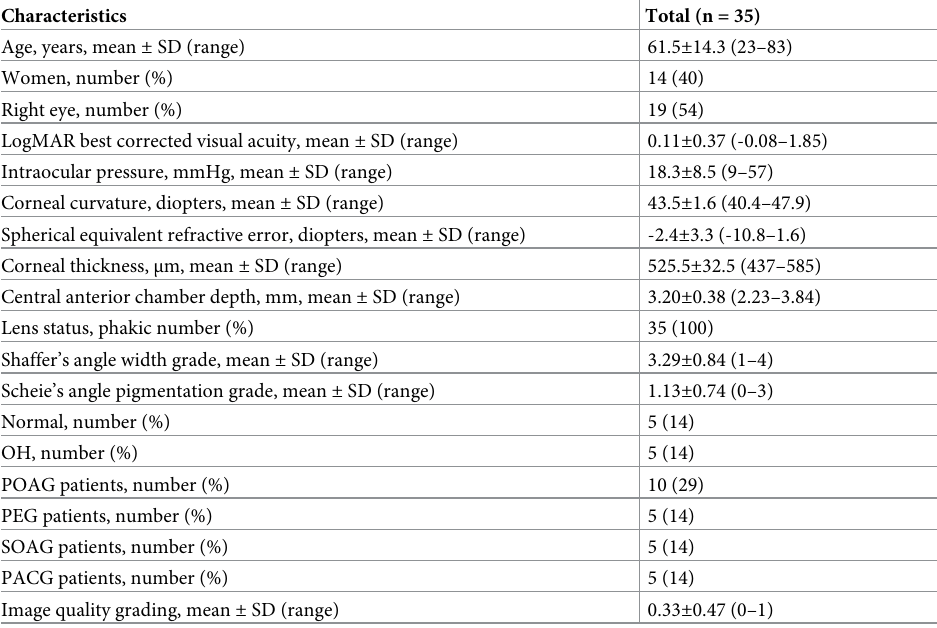
Table 1. Demographics and clinical characteristics of the study subjects. Characteristics Total (n = 35) Age, years, mean ± SD (range) 61.5 ± 14.3 (23–83) Women, number (%) 14 (40) Right eye, number (%) 19 (54) LogMAR best corrected visual acuity, mean ± SD (range) 0.11 ± 0.37 (-0.08–1.85) Intraocular pressure, mmHg, mean ± SD (range) 18.3 ± 8.5 (9–57) Corneal curvature, diopters, mean ± SD (range) 43.5 ± 1.6 (40.4–47.9) Spherical equivalent refractive error, diopters, mean ± SD (range) -2.4 ± 3.3 (-10.8–1.6) Corneal thickness, μ m, mean ± SD (range) Central anterior chamber depth, mm, mean ± SD (range) 3.20 ± 0.38 (2.23–3.84) Lens status, phakic number (%) 35 (100) Shaffer’s angle width grade, mean ± SD (range) 3.29 ± 0.84 (1–4) Scheie’s angle pigmentation grade, mean ± SD (range) 1.13 ± 0.74 (0–3) Normal, number (%) OH, number (%) 5 (14) POAG patients, number (%) 10 (29) PEG patients, number (%) 5 (14) SOAG patients, number (%) 5 (14) PACG patients, number (%) 5 (14) Image quality grading, mean ± SD (range) 0.33 ± 0.47 (0–1) LogMAR = logarithm of the minimum angle of resolution; OH = ocular hypertension; POAG = primary open-angle glaucoma; PEG = pseudoexfoliation glaucoma; SOAG = secondary open-angle glaucoma; PACG = primary angle- closure glaucoma; SD = standard